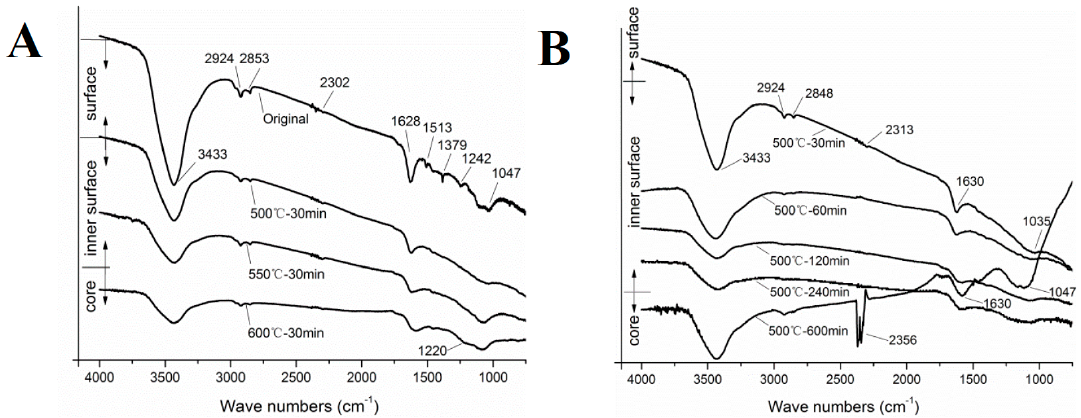
Figure 10. FTIR spectra of carbon fibers: ( A ) exposed to different temperatures for 30 min; ( B ) exposed at 500 °C for different times .